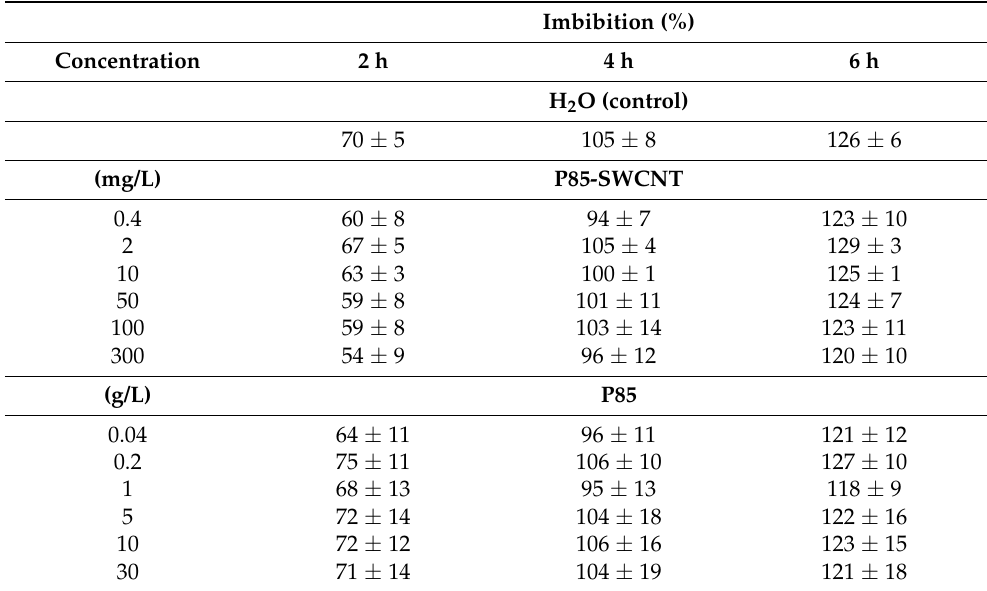
Table 1. Imbibition (%), of hydro-, P85-SWCNT-, and P85-primed pea seeds for a period of 2–6 h. Mean values ( ± SE, n = 150). The data are not statistically different from the hydro-primed sample according to Student’s t -test at p <